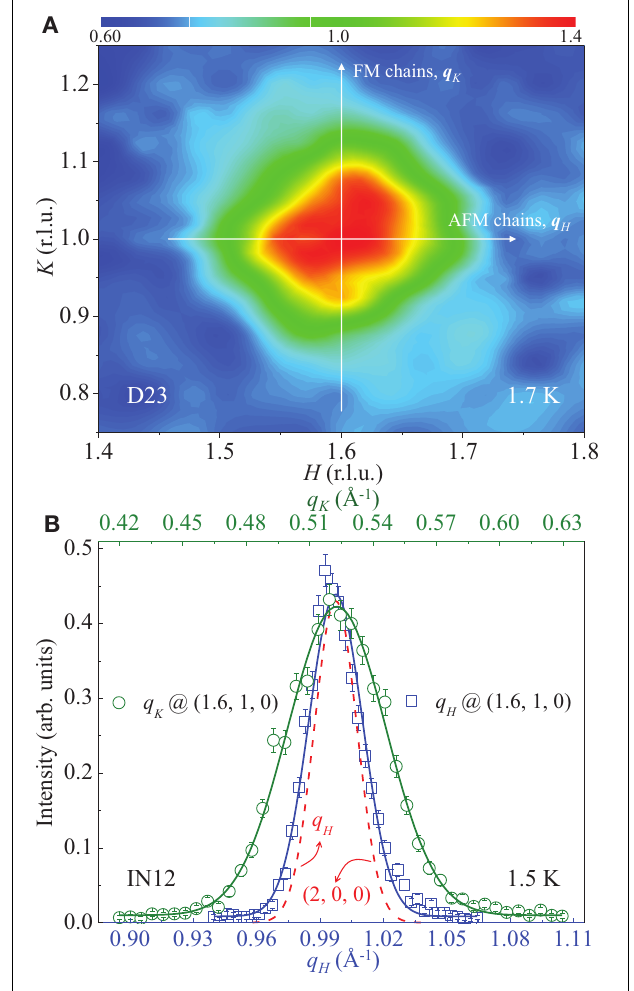
FIGURE 5 | Anisotropic in-plane spin correlations of SrTb 2 O 4 . (A) Unpolarized neutron data around the AFM (1.6, 1, 0) Bragg reflection measured at 1.7K using D23 (ILL). The two perpendicular arrows point out the directions of q H (i.e., the in-plane AFM chains) and q K (i.e., the in-plane FM chains), respectively. (B) Unpolarized neutron data around the (1.6, 1, 0) (void symbols) and the (2, 0, 0) (dashed line) Bragg peaks measured at 1.5K using IN12 (ILL). For comparison, the q H values around the nuclear (2, 0, 0) Bragg peak are reduced by 0.2547 Å − 1 . The solid lines are Gaussian fits to the magnetic data convoluted with the nuclear correlation length as expected Q